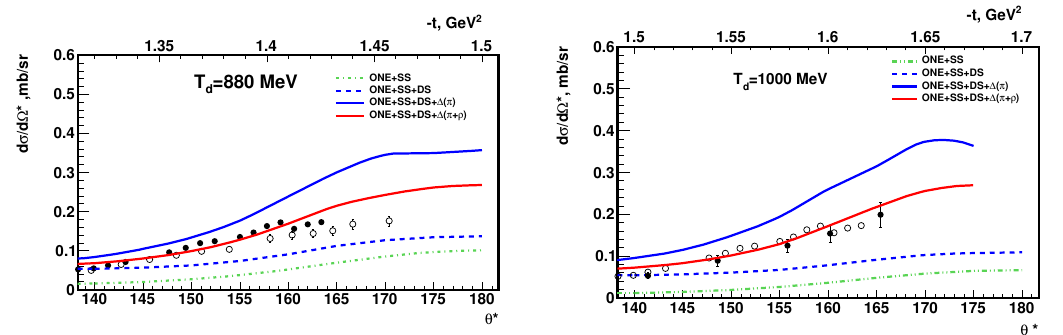
Figure 2: The angular dependence of the differential cross section at the deuteron energy T